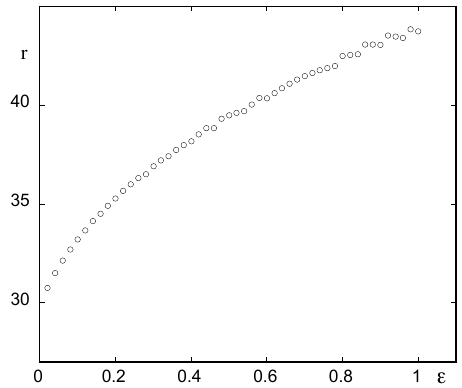
Figure 5. Time evolution of variable x of model (13) expressed in terms of the instantaneous value of r with (cid:15) = 0 . 01 and initial condition x = x − , y = y − , z = r 0 − 1.